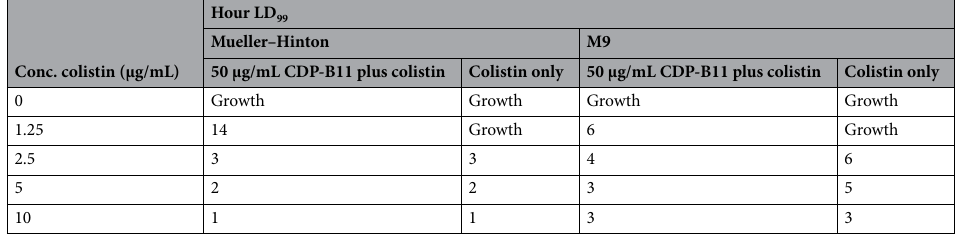
Table 2. Time kill assay results for E. coli #0346 in Mueller–Hinton and M9 media.